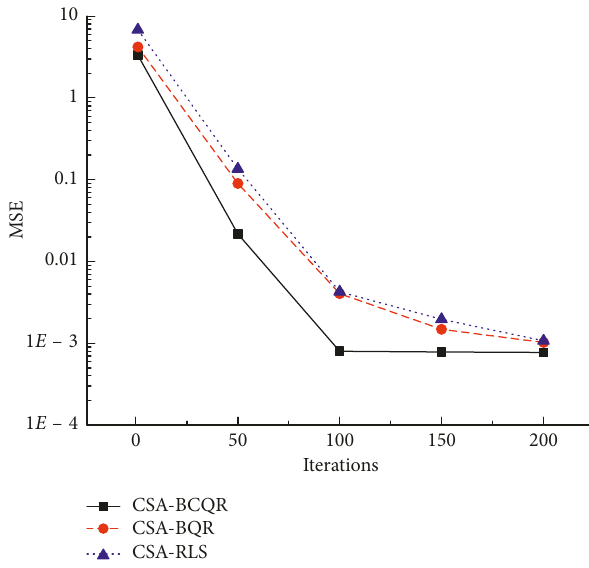
Figure 6: MSE of the nonlinear